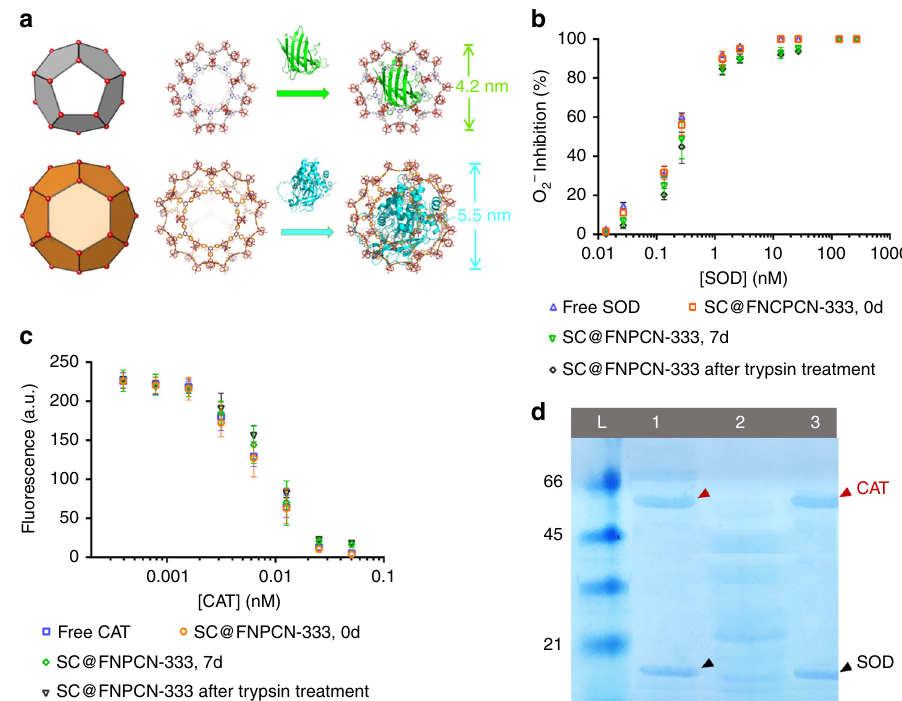
Fig. 2 Enzyme encapsulation and in vitro determination of enzymatic activities. a Schematic representation illustrating the relative size of the cavities present in FNPCN-333 and of the enzymes SOD and CAT (from PDB 1CBJ and 5GKN). The medium (gray) and large (orange) cavities of FNPCN-333 accommodate SOD (green) and CAT (cyan), respectively. b Relative enzymatic activities of several SOD formulations, as determined by the superoxide inhibition assay: free SOD (blue), freshly prepared SC@FNPCN-333 (orange), SC@FNPCN-333 stored for 7 days (green), SC@FNPCN-333 treated with trypsin for 2 h (black). n = 3, mean ± s.d. c Relative enzymatic activities of several CAT formulations, as measured by the inhibition of H 2 O 2 -mediated production of the fl uorophore resoru fi n: free CAT (blue), freshly prepared SC@FNPCN-333 (orange), SC@FNPCN-333 stored for 7 days (green), SC@FNPCN-333 treated with trypsin for 2 h (black). n = 3, mean ± s.d. d SDS-PAGE analysis of SC@FNPCN-33 after exposure to the protease trypsin. L: protein ladder. Lane 1: free SOD (highlighted with black arrow) and CAT (highlighted with red arrow). Lane 2: Free SOD and CAT after treatment with trypsin for 1 h. Lane 3: SC@FNPCN-333 treated with trypsin for 1 h (analyzed after dissolution of MOF in